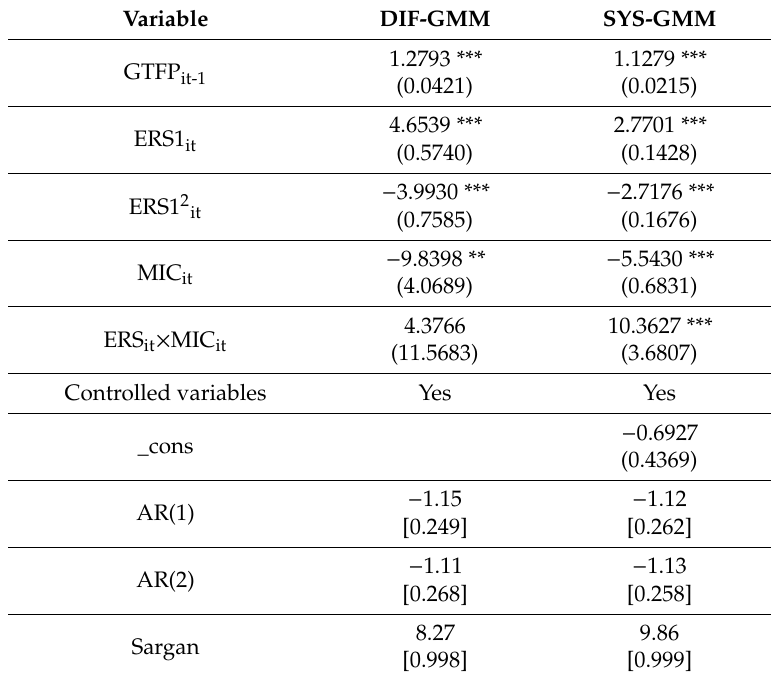
Table 4. The robustness test results after the explanatory variables are